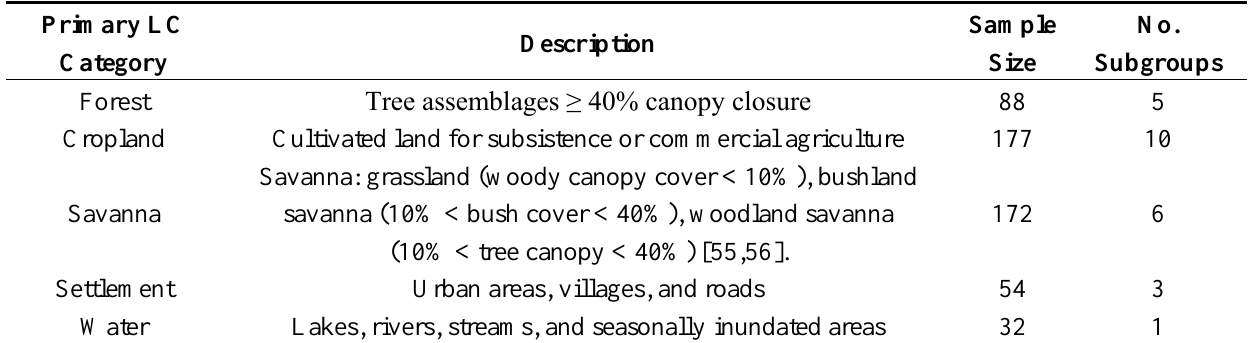
Table 1. Primary category training data for footprint at Path: 172 Row: 071: category description, sample size, and number of subgroups. Column 3 indicates the total number of training samples for each primary category. Column 4 indicates the number of subgroups generated from the hierarchical clustering of training signatures.